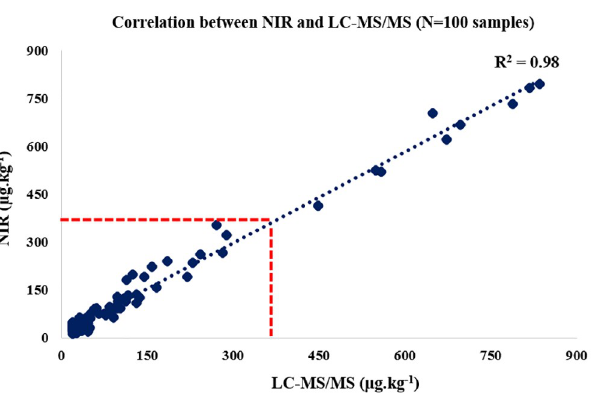
Fig 5. External validation of zearalenone: Correlation between Near Infrared Spectroscopy (NIR) and Liquid Chromatography Coupled to Tandem Mass Spectrometry (LC-MS/MS) in ground